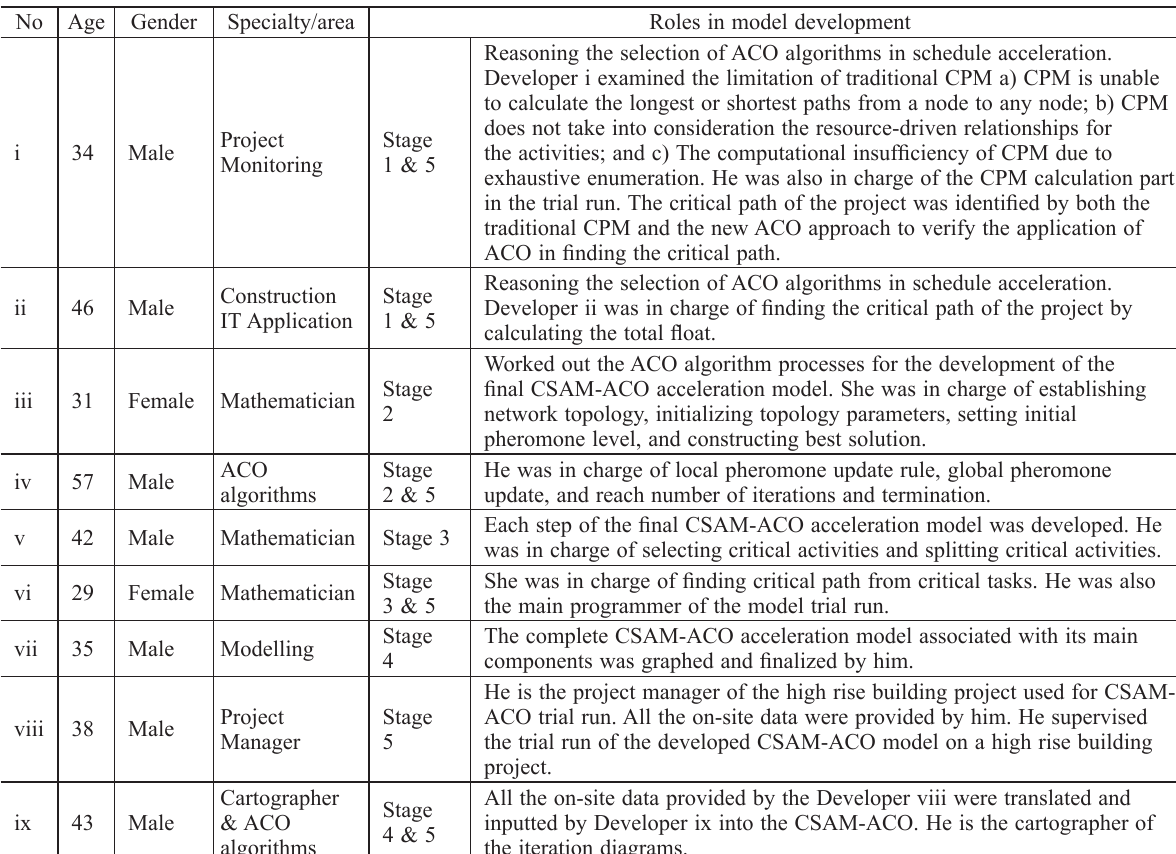
Table 2. Profiles of CSAM-ACO development team No